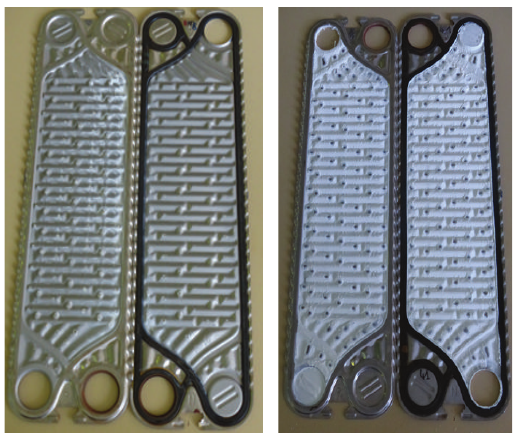
Figure6: Picturesof thedeposit collected onheat exchanger surface in the second and last channels of the